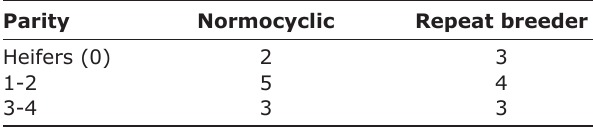
Table-2: Parity of normocyclic and repeat breeder cows.